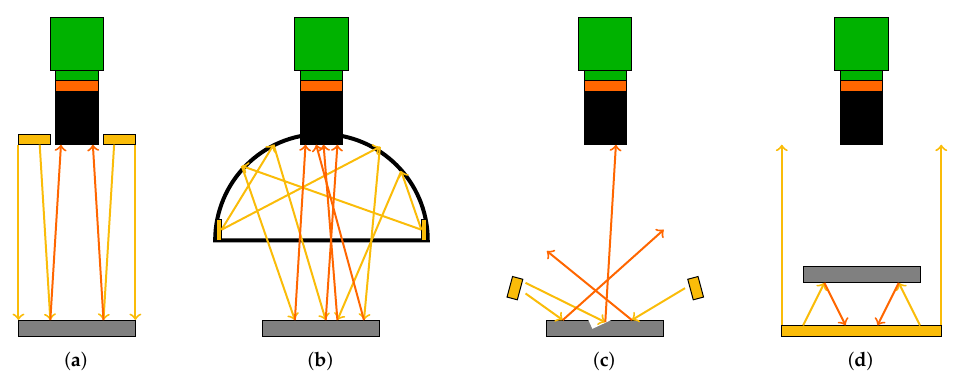
Figure 12. Different lighting techniques: ( a ) direct incident lighting, ( b ) diffuse lighting, ( c ) dark field illumination, and ( d ) transmitted light